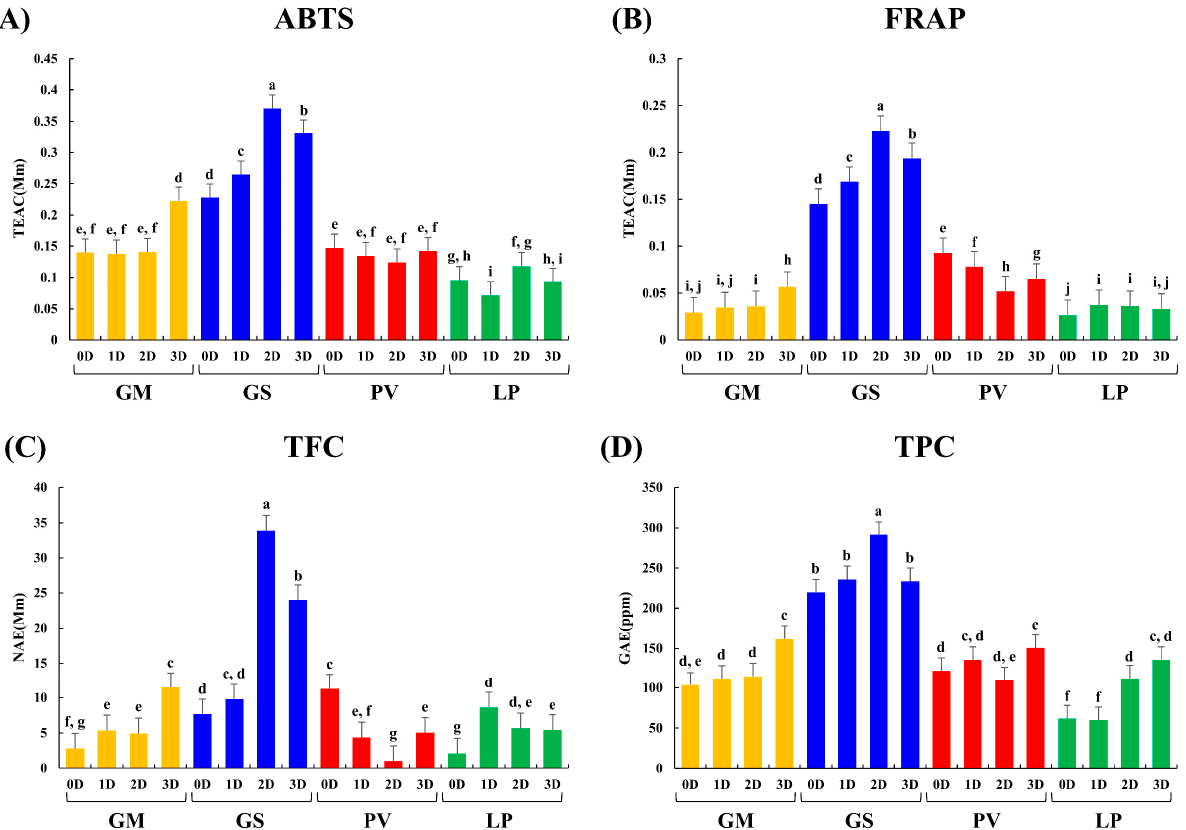
Figure 5. The antioxidant activity test, total flavonoids, and phenolic contents. ( A ) 2,2 ′ -azino-bis (3- ethylbenzothiazoline-6-sulfonic acid) diammonium salt [ABTS], ( B ) ferric reducing antioxidant power [FRAP], ( C ) total flavonoid contents [TFC], and ( D ) total phenolic contents [TPC]. The significance was determined using Duncan’s multiple range test, and different letters indicate significant differences ( p -value < 0.05). ■ (GM): G. max , ■ (GS): G. soja , ■ (PV): P. vulgaris , ■ (LP): L. pur-